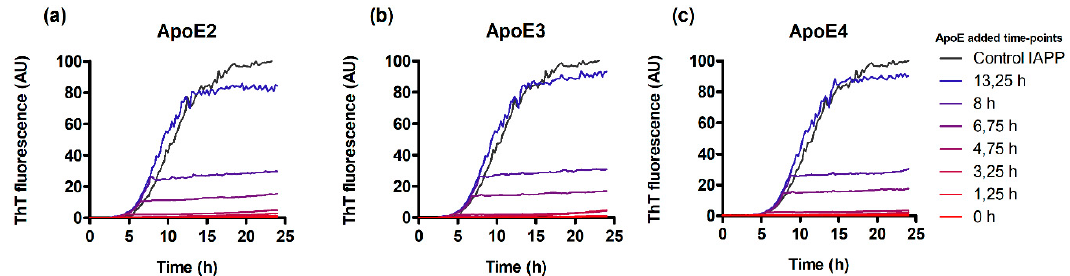
Figure 3. Effect of ApoEs on the elongation of IAPP during ThT binding kinetics. A total of 500 nM ApoE was added to the aggregating 5 µM IAPP at the indicated time points of the reaction. ApoE2 ( a ), ApoE3 ( b ), and ApoE4 ( c ).